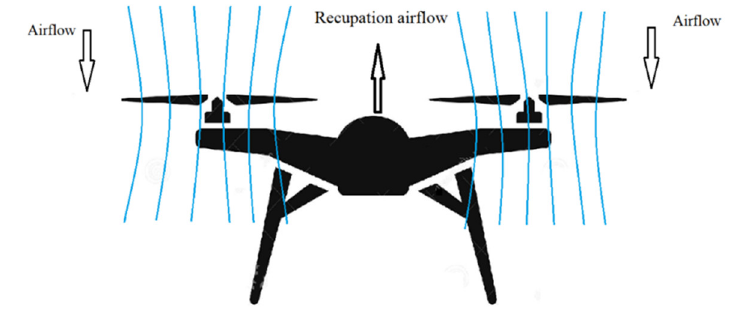
Figure 16. Air direction on charging mode [56].